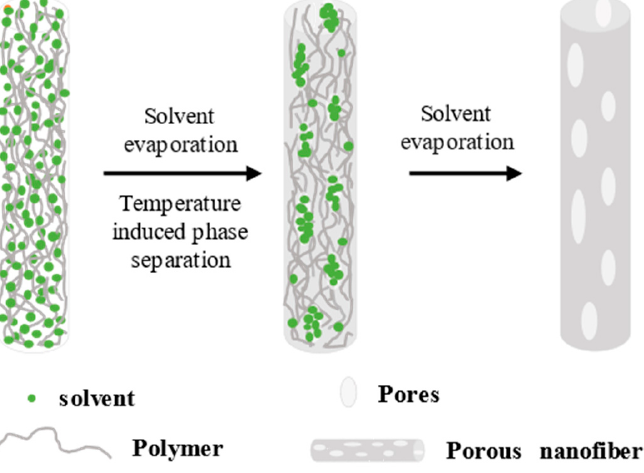
Figure 5. Schematic of the pore − forming mechanism of